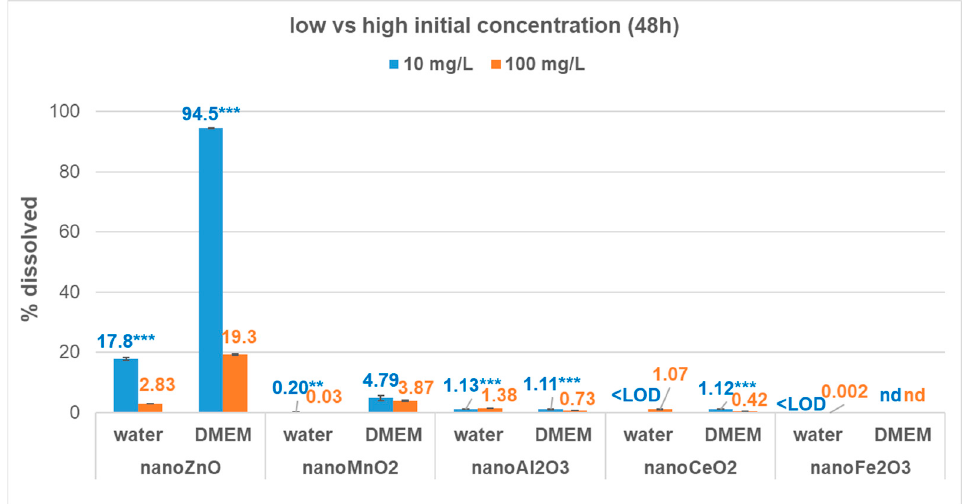
Figure 2. Influence of initial concentrations (10 mg/L vs. 100 mg/L) on % solubility of the ZnO, MnO 2 , CeO 2 , Al 2 O 3 , and Fe 2 O 3 ENMs in water and DMEM after 48 h of incubation (<LOD = below the limit of detection; nd = not detected). Results are presented as mean (standard deviation) of triplicates, and pH values are reported in Table S5A. For a given metal-oxide and medium, ‘**’ and ‘***’ indicate significant differences between 10 vs. 100 mg/L at α = 0.01 and 0.001, respectively, based on the Student’s t -test. See Figure S2 in the Supplementary Materials for absolute mass dissolved in water and DMEM.